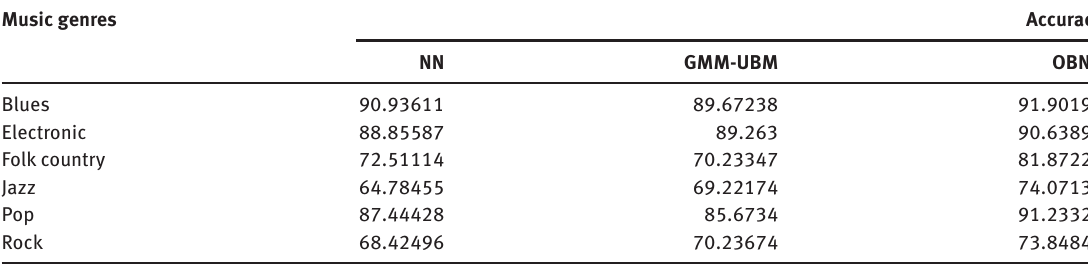
Table 1: Accuracy Evaluation Results between NN, GMM-UBM, and OBNN.